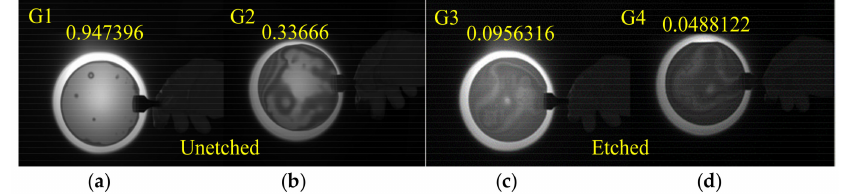
Figure 12. Images of different bonding results obtained by infrared camera. ( a ) Bonding results of unetched wafers with silica film; ( b ) Bonding results of unetched wafers without silica film; ( c ) Bonding results of etched wafers with silica film; ( d ) Bonding results of etched wafers without silica film.